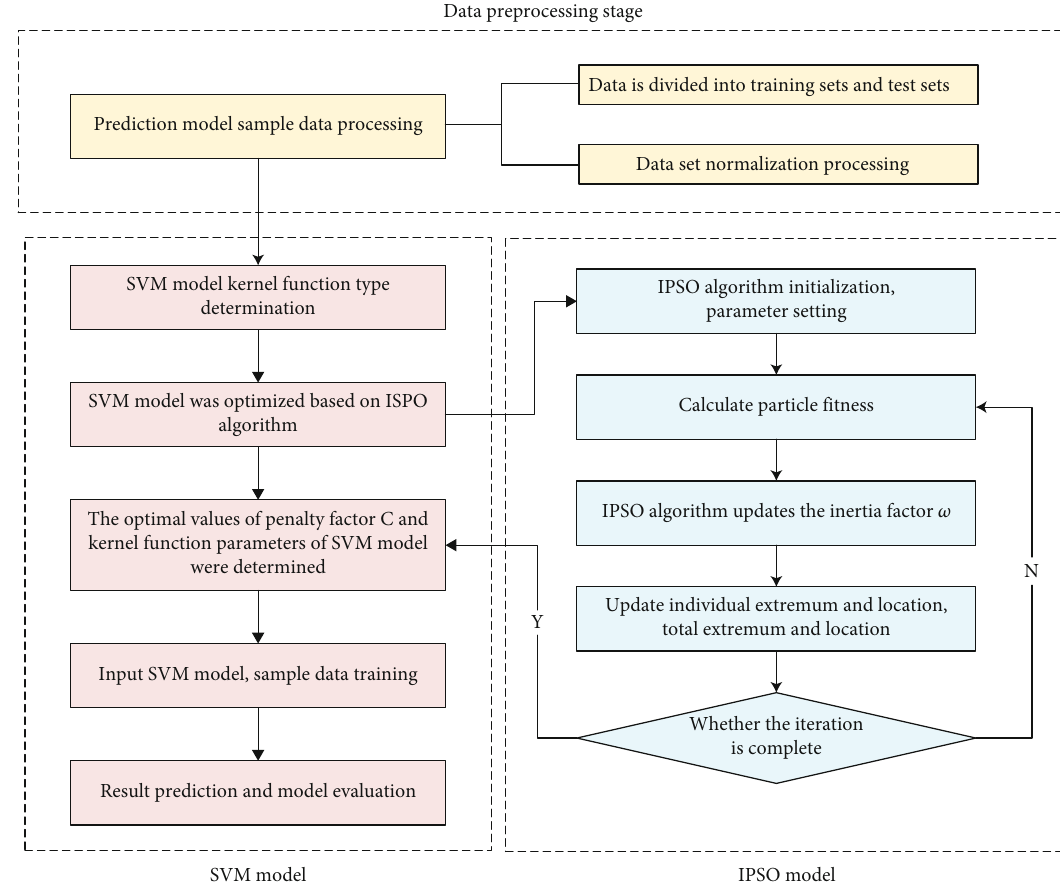
Figure 2: Schematic diagram of IPSO-SVM model